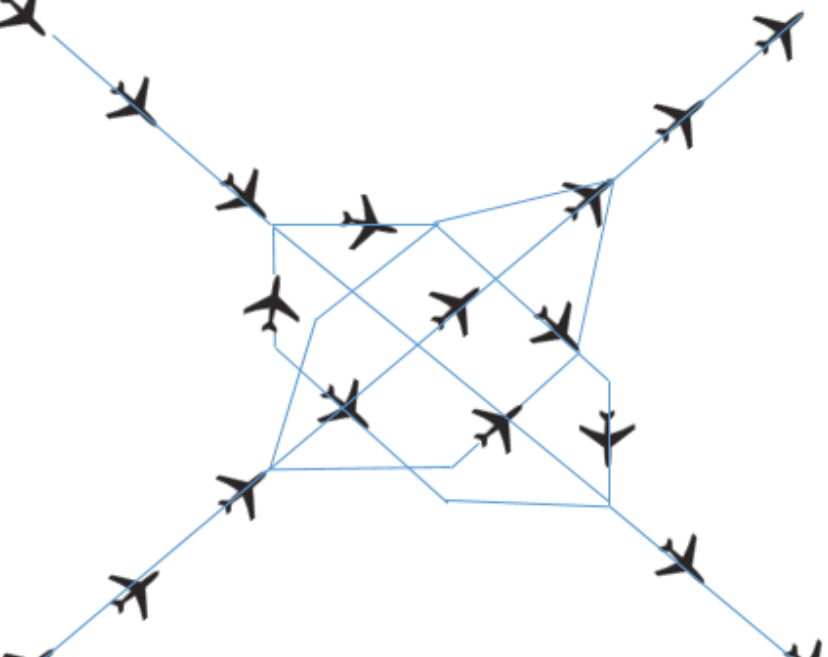
Figure 9. Miles-in-Trail scenario for the case of speed changes.